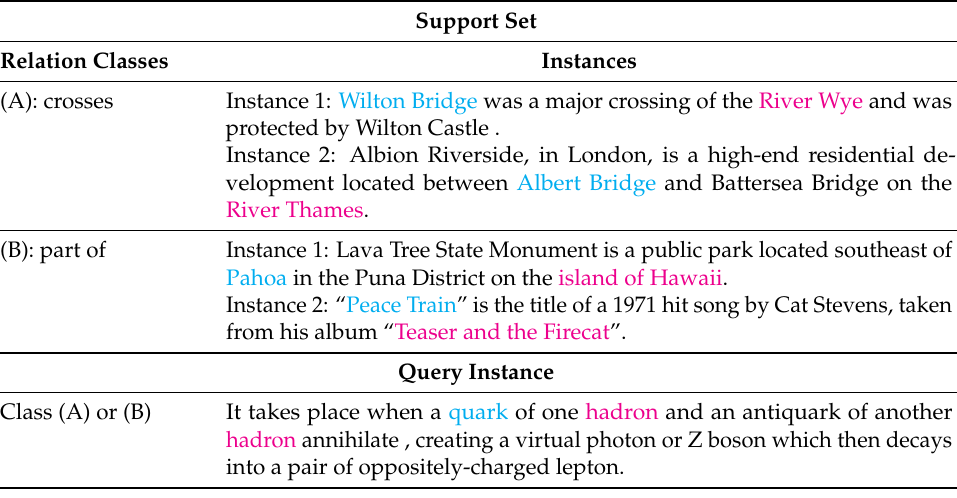
Table 1. Example of the support and query sets, where cyan represents head entities, and magenta denotes tail entities. In the query instance, the quark is part of a hadron; hence, it should be the part of